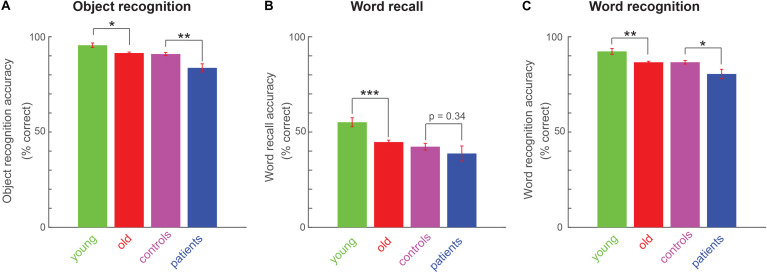
Explicit memory variations across age and cognitive impairments. (A) Object recognition accuracy (percentage correct) across all participant groups. Asterisks indicate statistical significance comparing participant-wise accuracy using a rank-sum test. Conventions are as before. (B) Word recall performance (percentage correct) across all four participant groups, with conventions as in (A). (C) Word recognition performance (percentage correct) across all four participant groups, with conventions as in (A).